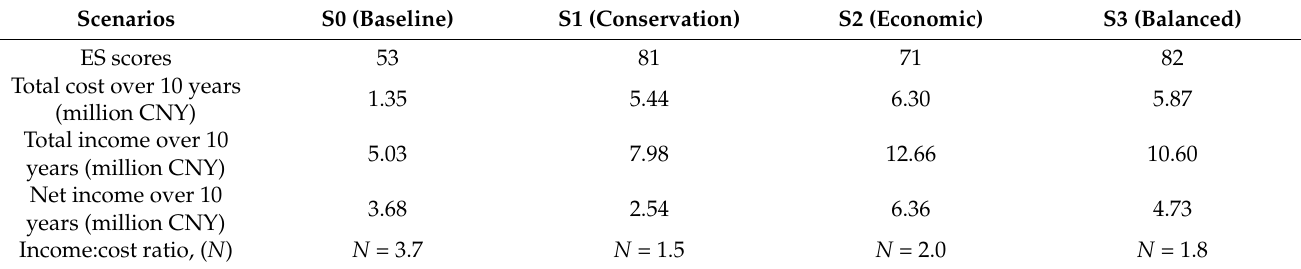
Figure 5. The scores of 14 indicators and 4 categories of ES. ( a ) The scores of 14 indicators in all scenarios. ( b ) The scores of 4 categories in all scenarios. Table 7. The ES scores and economic data over 10 years among the four